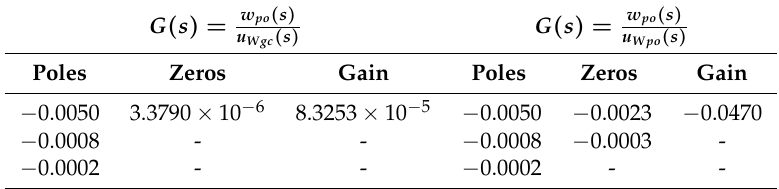
Table 4. Poles, zeros and gain of system transfer functions—Ribeiro’s